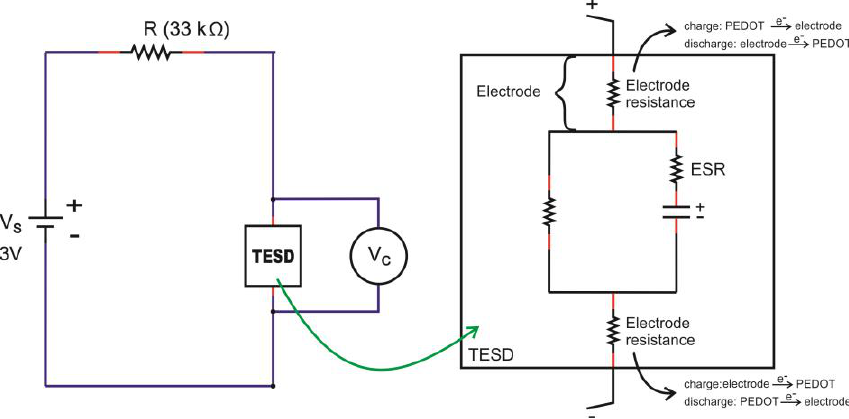
Figure 11. Possible configuration of the electronic system in the TESD cell with capacitive behavior.